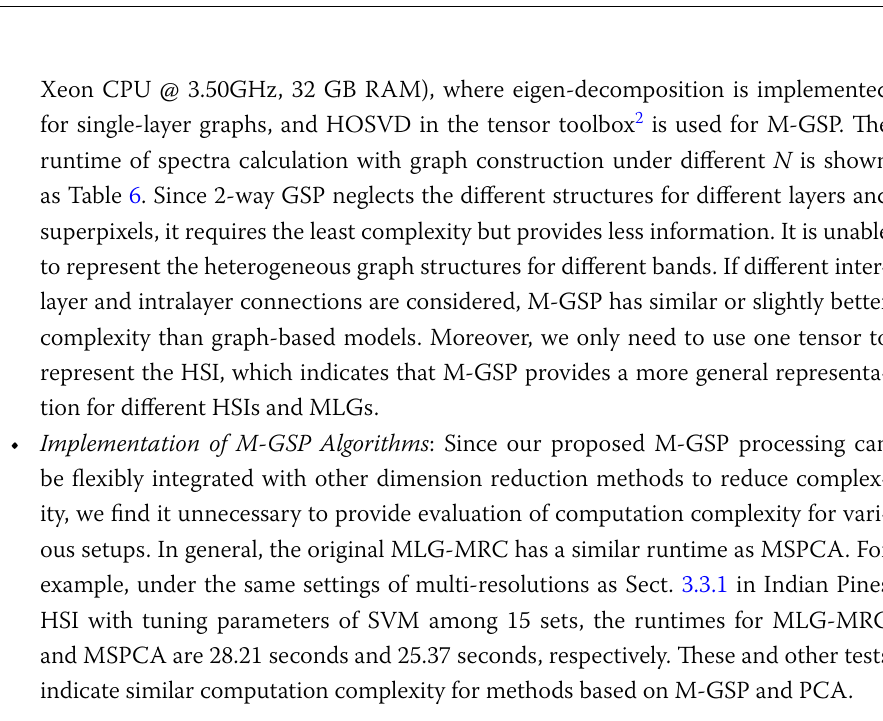
Table 7 Performance under different regrouping ratio Regrouping ratio